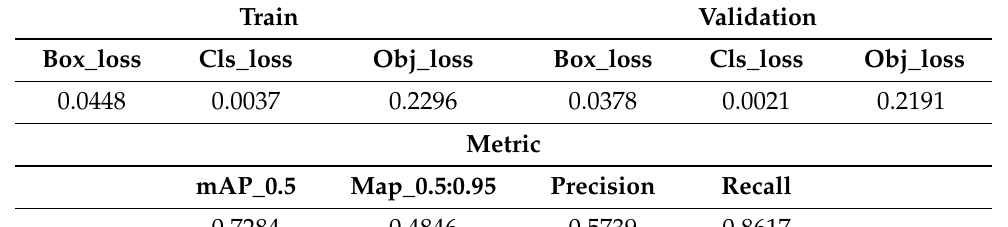
Table 4. The result of training the YOLOv5s model.